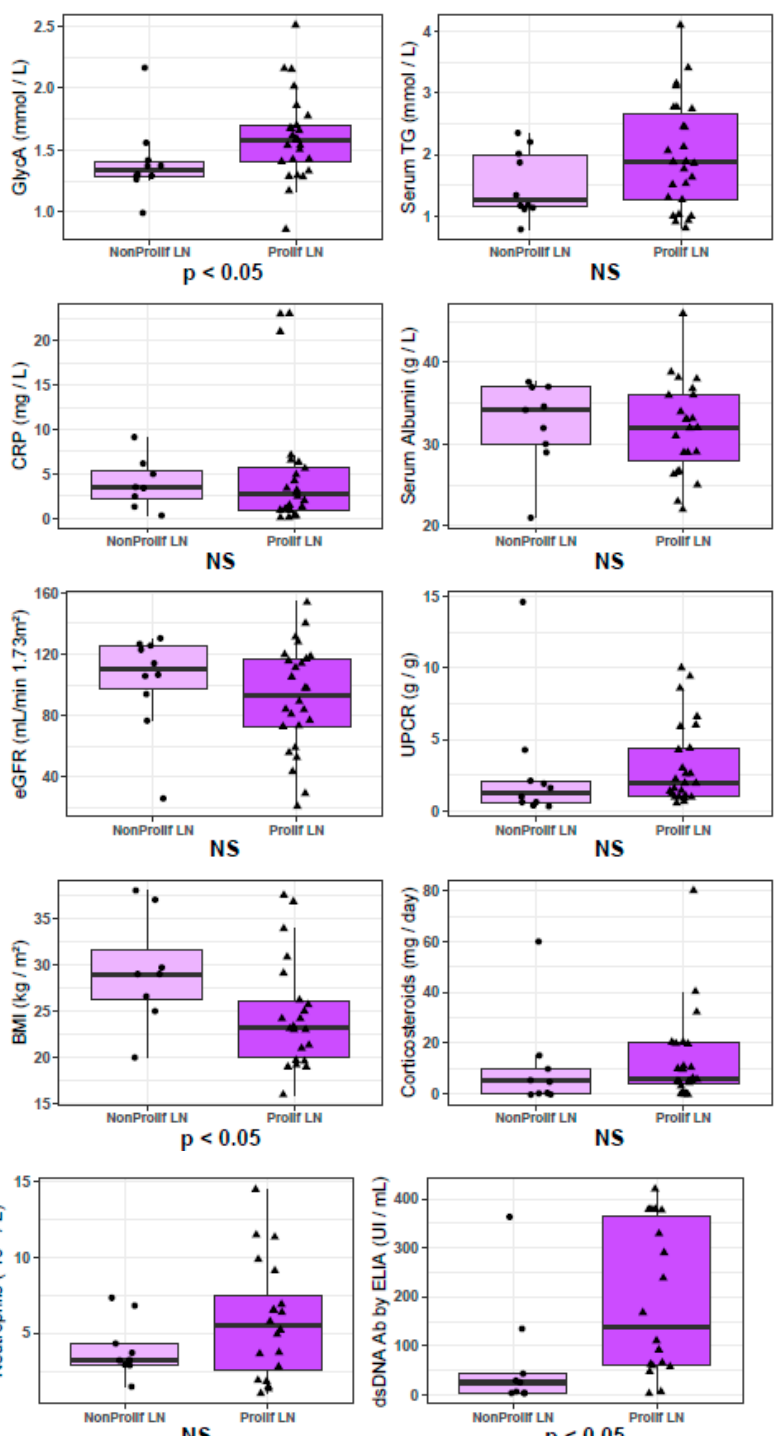
Figure 4. Comparison of samples taken at the time of renal biopsy, between patients with non-proliferative versus proliferative lupus nephritis. Significance of Mann-Whitney-Wilcoxon U tests comparing the groups are indicated below each panel. Patients with proliferative lupus nephritis (ProlifLN, n = 26) display significantly higher Glycoprotein Acetylation (GlycA) levels than patients with non-proliferative lupus nephritis (NonProlifLN, n = 26), although they have significantly lower BMI. Patients with proliferative LN also display higher levels of anti-dsDNA antibodies. Complete results are listed in Table 3.